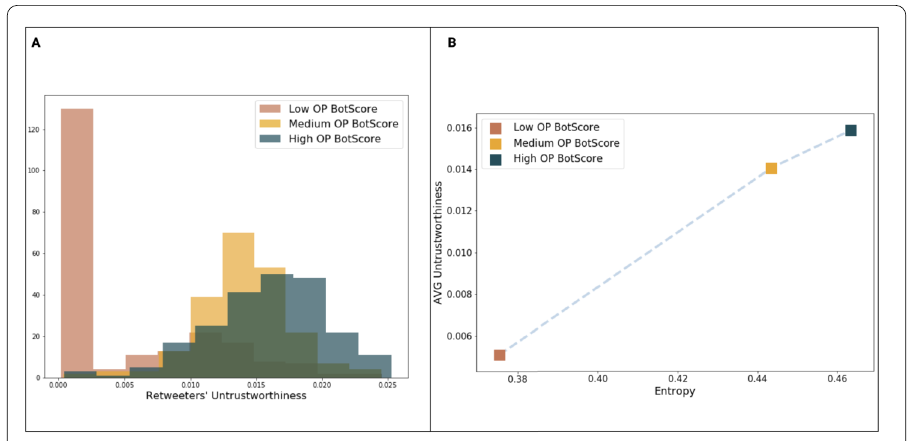
Figure 5 ( A ) Distribution of the Untrustworthiness of the retweeters disaggregated by the BotScore of the OPs. BotScore is divided into tertiles. A shift to the right can be observed as we go up the quantile ladder, displaying once again a positive relationship between the two measures; ( B ) Relationship between Entropy, average Untrustworthiness, and BotScore of the OPs. BotScore is divided into tertiles; once again, a positive relationship between the measures involved can be